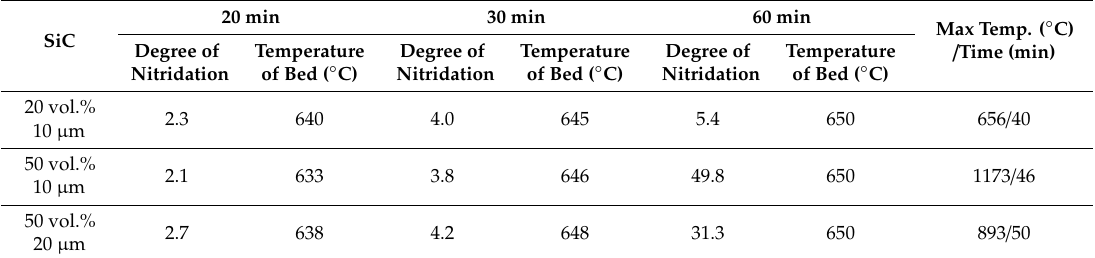
Figure 2. Temperature variation of SiC/6061Al composites during heating at 650 °C in nitrogen gas: (a) various volume fractions and sizes of SiC (20 and 50 vol.%, 10 and 20 μm); (b) 20 vol.%, 20 μm SiC. Table 1. Degree of nitridation and temperature of the SiC/6061 Al composite powder bed after heating at 650 °C for 20, 30, and 60 min.